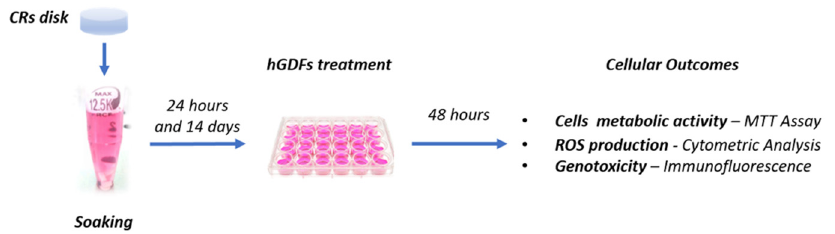
Figure 1. Experimental Plan. Soaking-derived extracts were obtained following the immersion of each type of CR disks of 50.27 mm 2 surface in the culture medium (CTRL) for 24 h and 14 days (i.e., 2 CR disks in 1 mL of CTRL). The hGDFs isolated from human gingival biopsies were treated for 48 h with the culture medium (CTRL) or with the soaking extracts (24 h and 14 days) derived from the five selected CRs. Cell viability, ROS production, and genotoxicity were chosen as cellular outcomes.